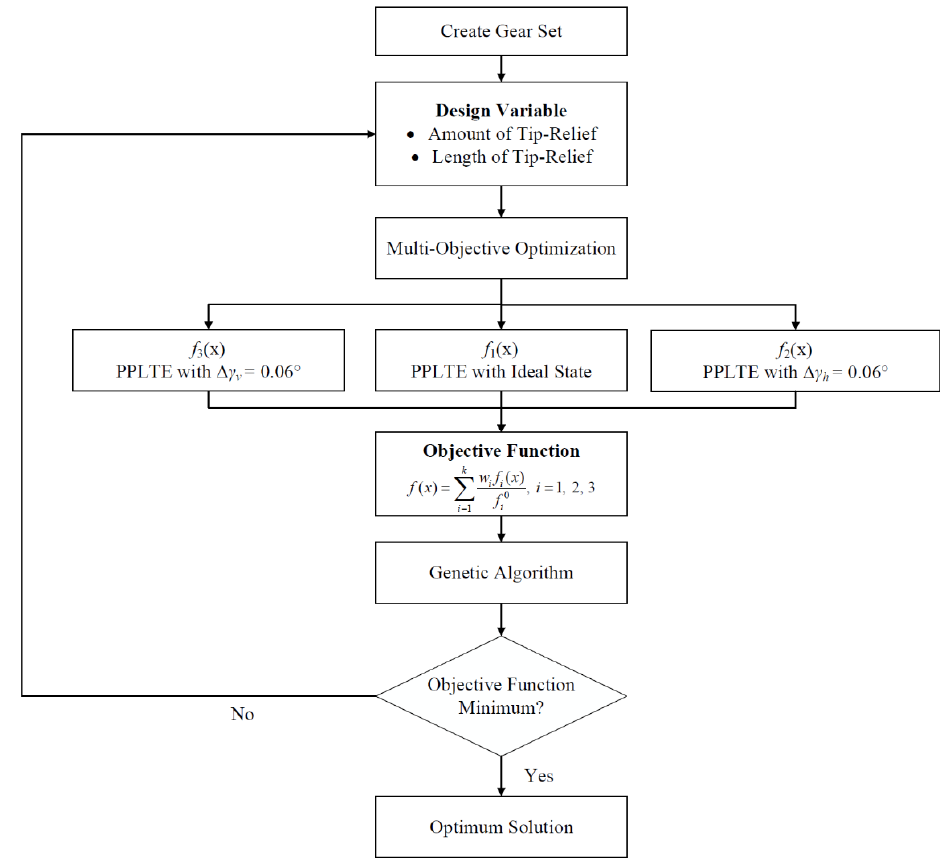
Figure 6. Optimization analysis flowchart. Table 5. PPLTE improvements in the optimum design. (Unit: µ